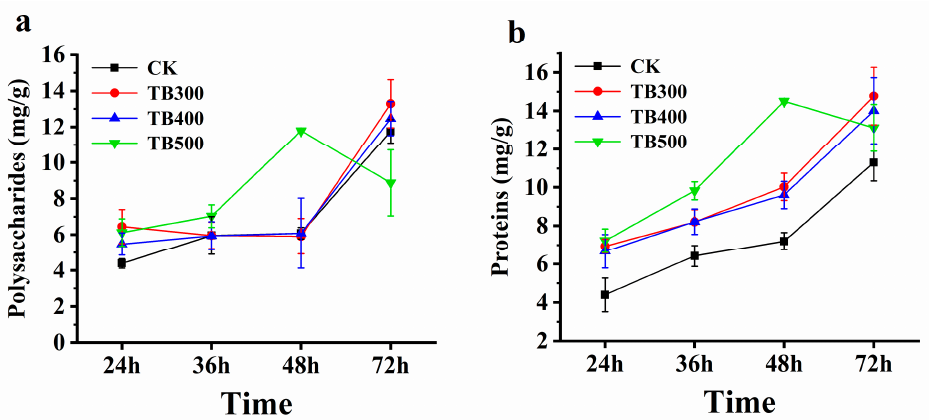
Figure 3. Effects of biochar on the content of ( a ) polysaccharides and ( b ) proteins of EPS in Tpb55.